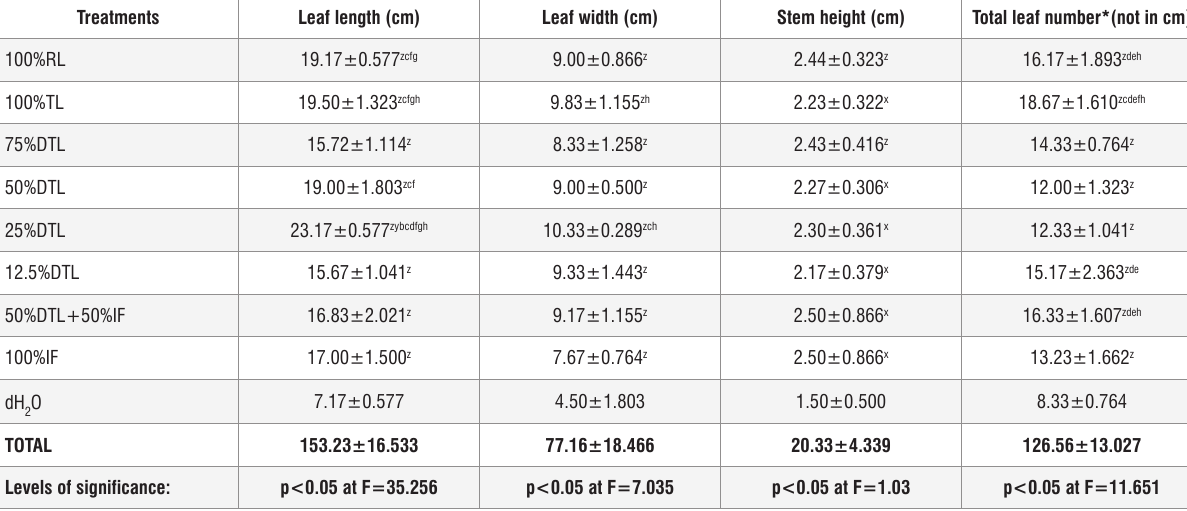
Table 4: Comparison of leaf length, leaf width, stem height and total leaf number for Brassica rapa L . after 56 days Treatments